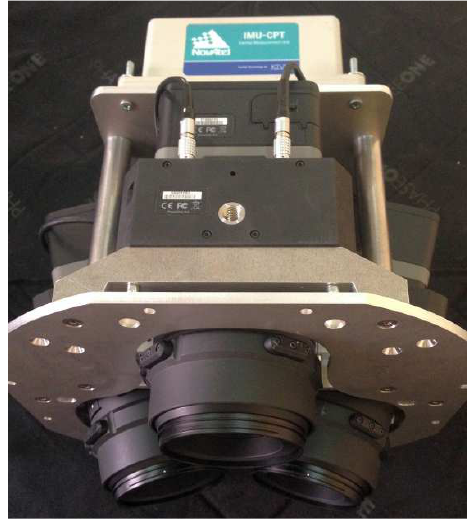
Figure 1: setup of a camera-triple with GNSS-INS